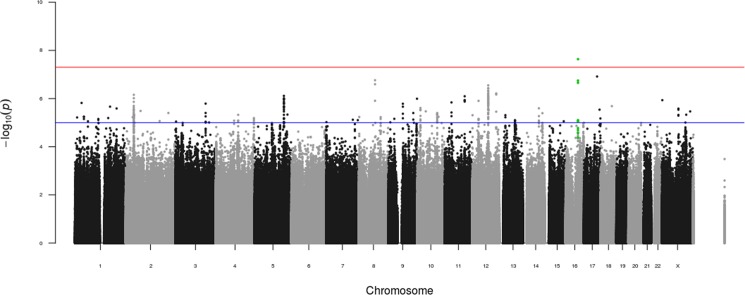
Manhattan plot for genome-wide association analyses of rotator cuff injury.The log10 p-values for association with rotator cuff injury for 10,582,947 SNPs from the meta-analysis from this study are plotted by genomic position with chromosome number listed across the bottom. The y-axis shows the -log10 p-value for association with rotator cuff injury. The blue line represents suggestive genome-wide significance (p<1x10-5) and the red line represents genome-wide significance (p<5x10-8). The top SNP rs71404070 and the nine other SNPs within the same linkage disequilibrium block at suggestive significance are highlighted in green.